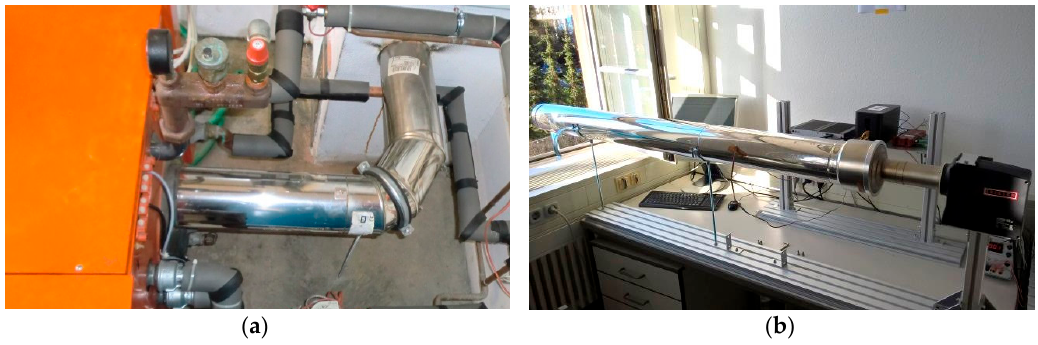
Figure 3. Real system versus mockup: ( a ) Real oil-fired heating on the campus; ( b ) Heating mockup in the laboratory.